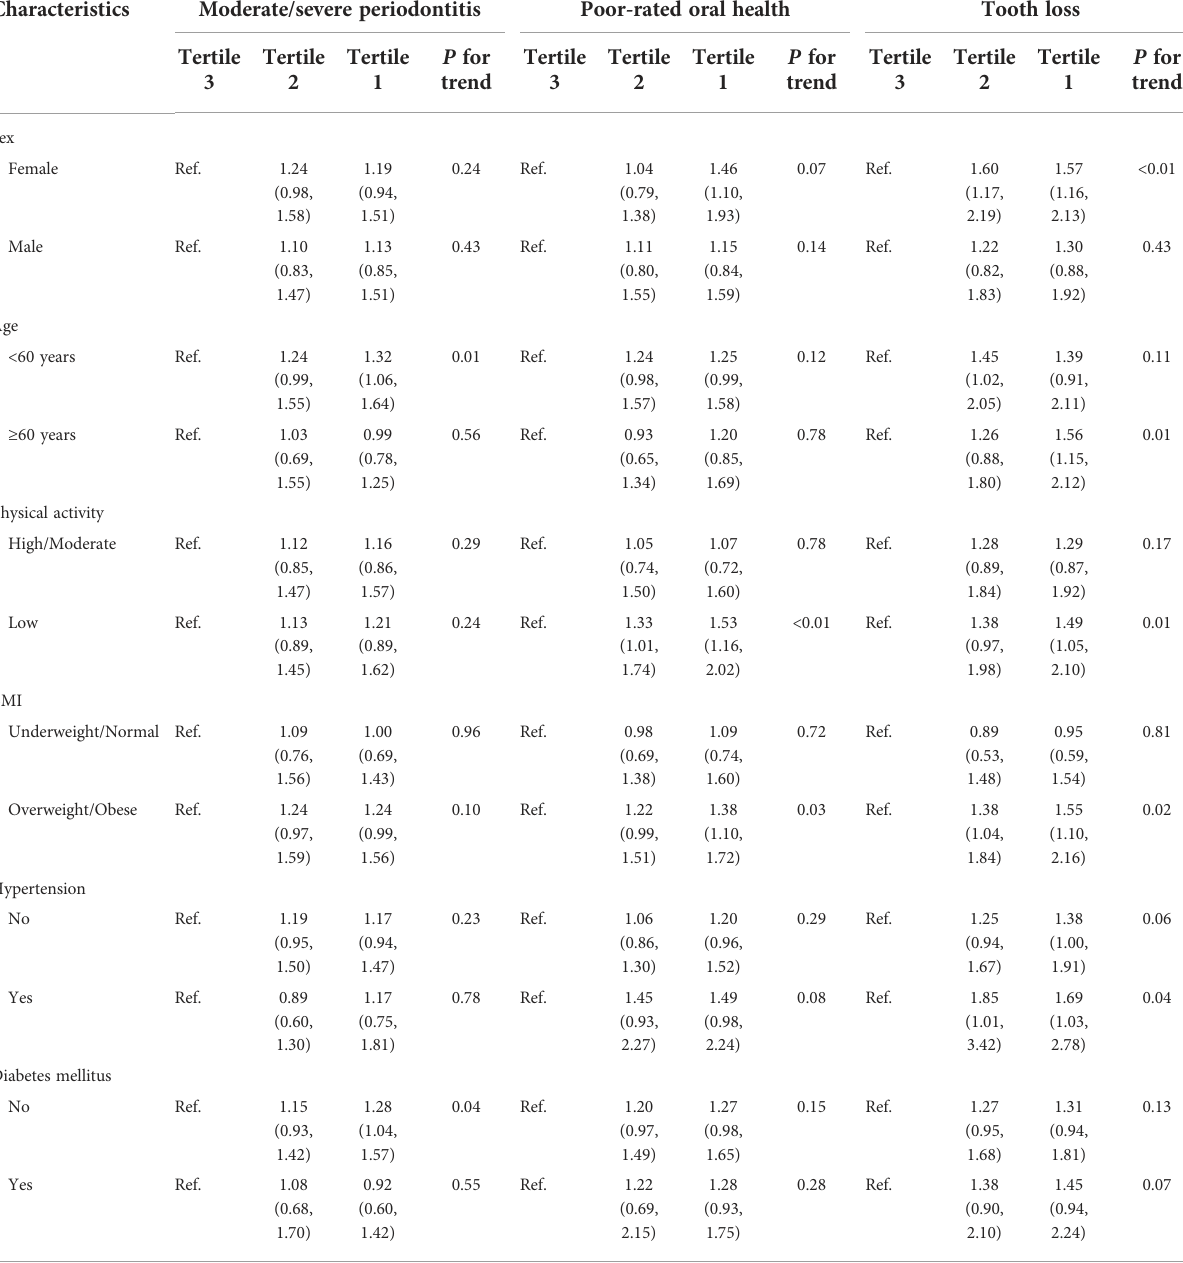
TABLE 3 Weighted ORs (95%CIs) of the association between a - klotho and oral health in strati fi ed analyses.